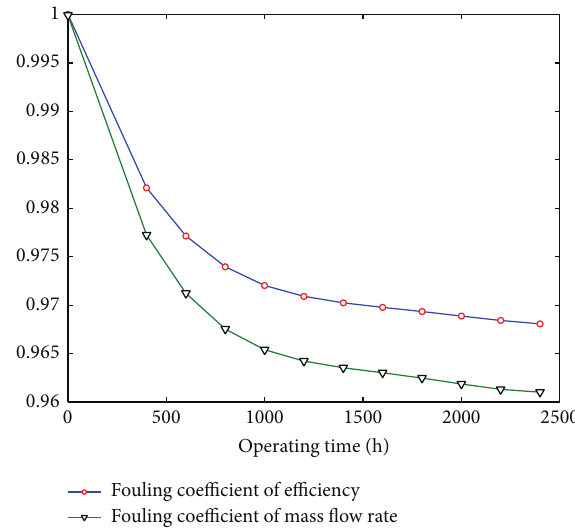
Figure 4: Fouling coefficients of mass flow rate and